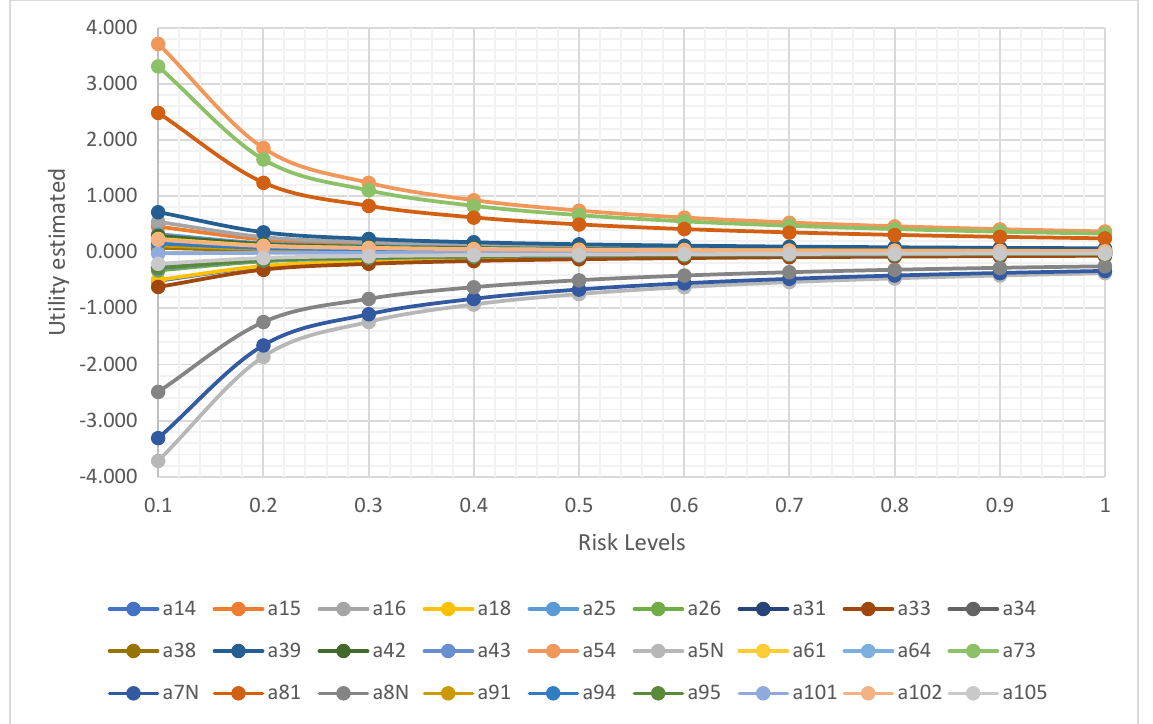
Figure 5. Trend of risk level toward seaport risk factors.